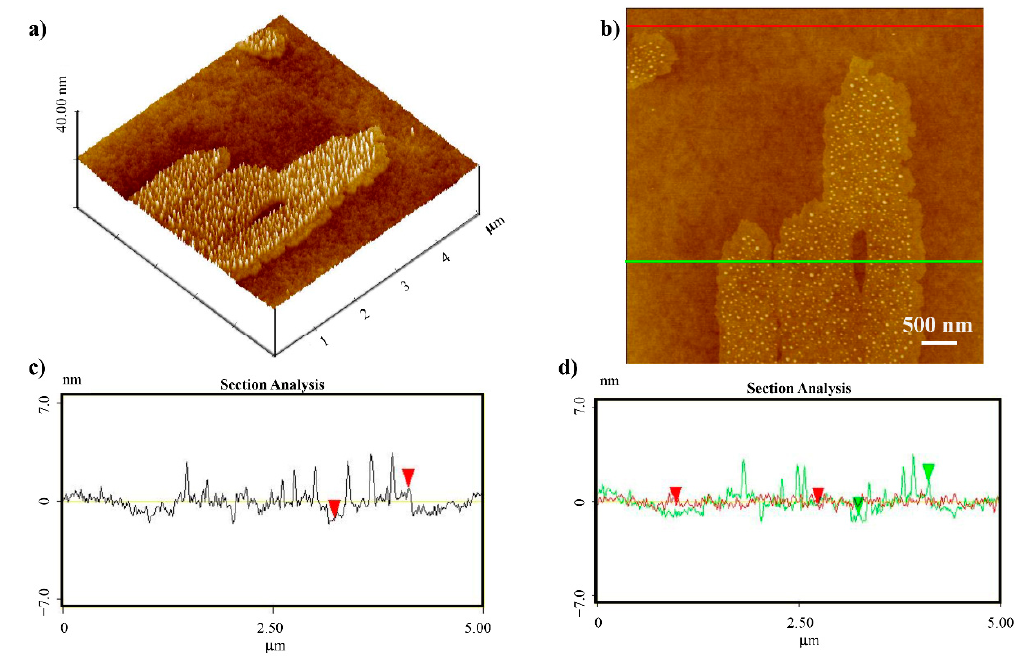
Figure 6. AFM 3D topographies ( a ) of the thin film of StarP deposited on PHMS/Si and relative profile ( b – d ).